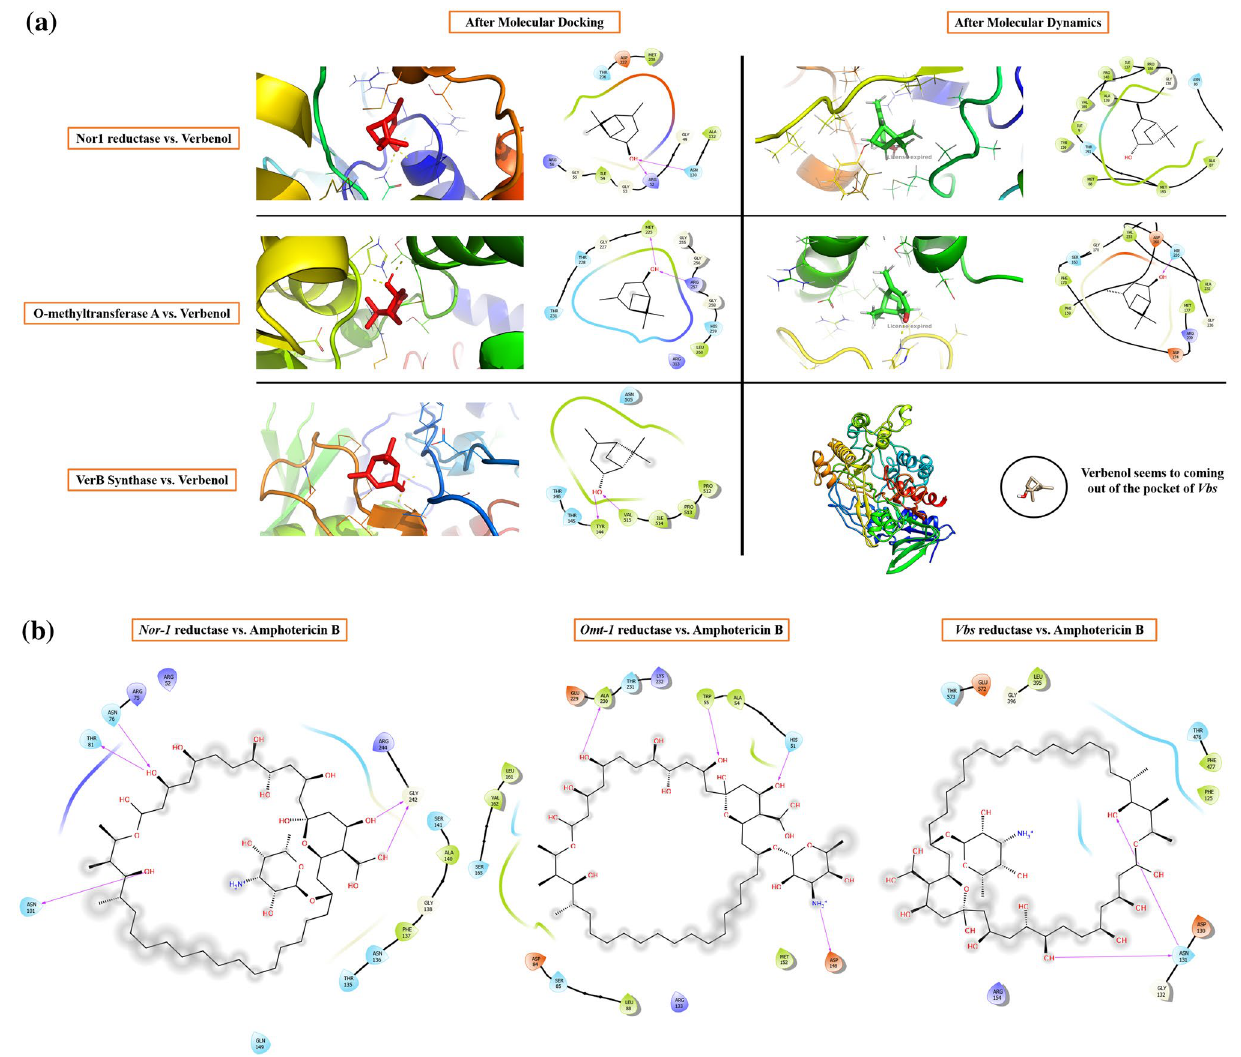
Figure 4. ( a ) Interactive behavior of target proteins with verbenol; ( b ) the binding details of amphotericin with target proteins; ( c ) B-factor profiling of proteins and protein-verbenol